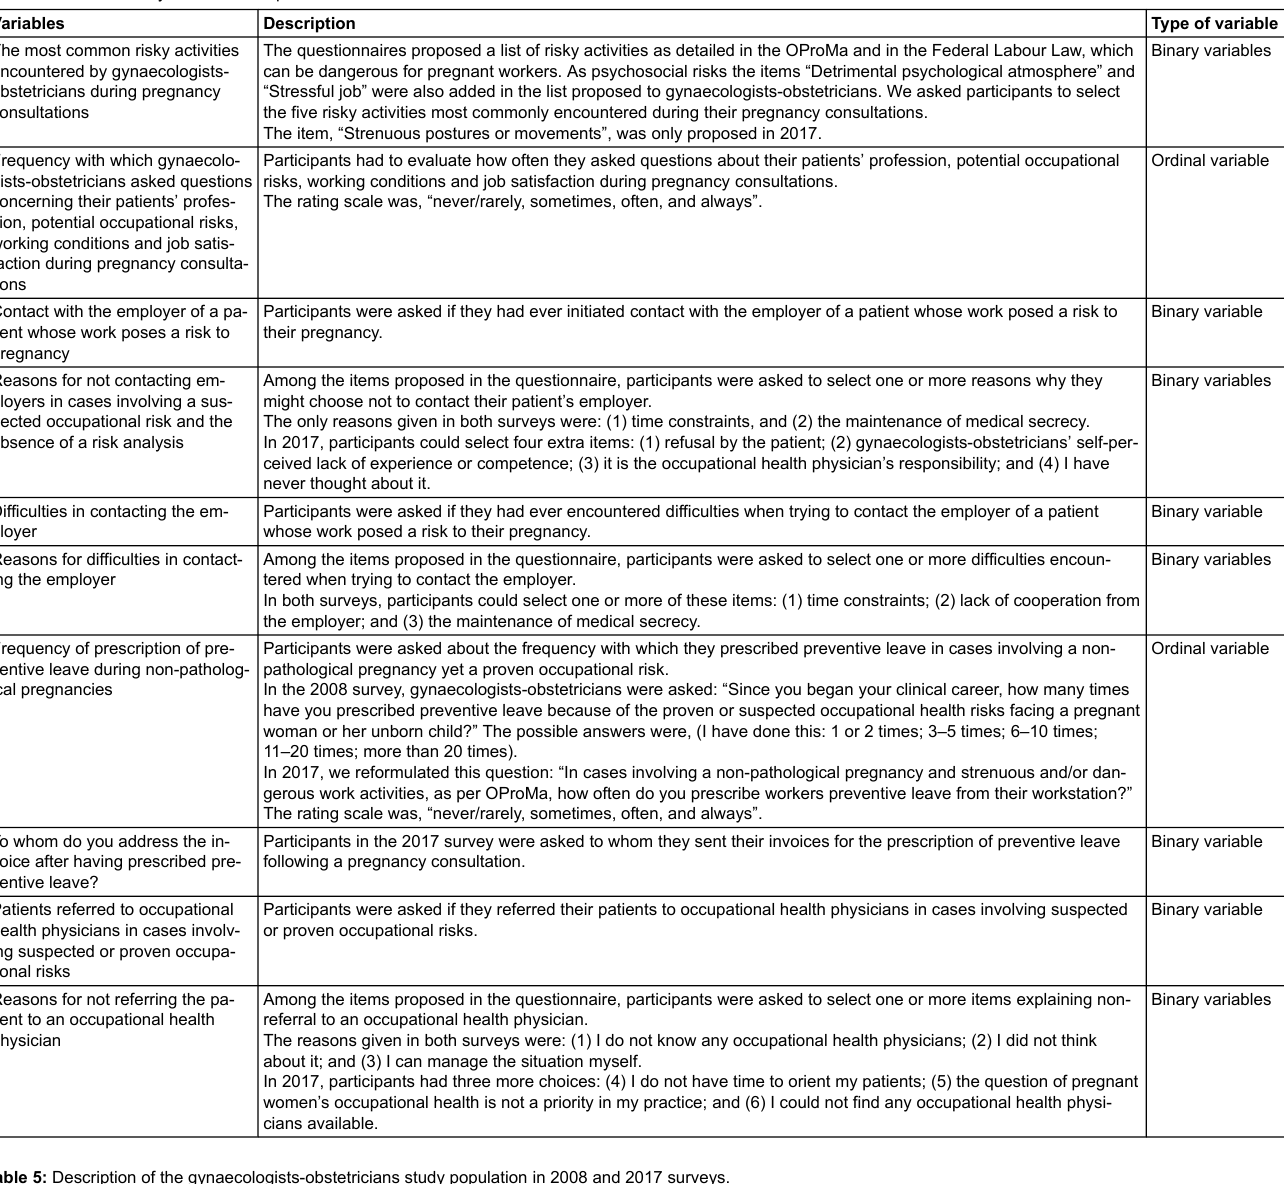
Table 4: Variables analysed and description of these items.